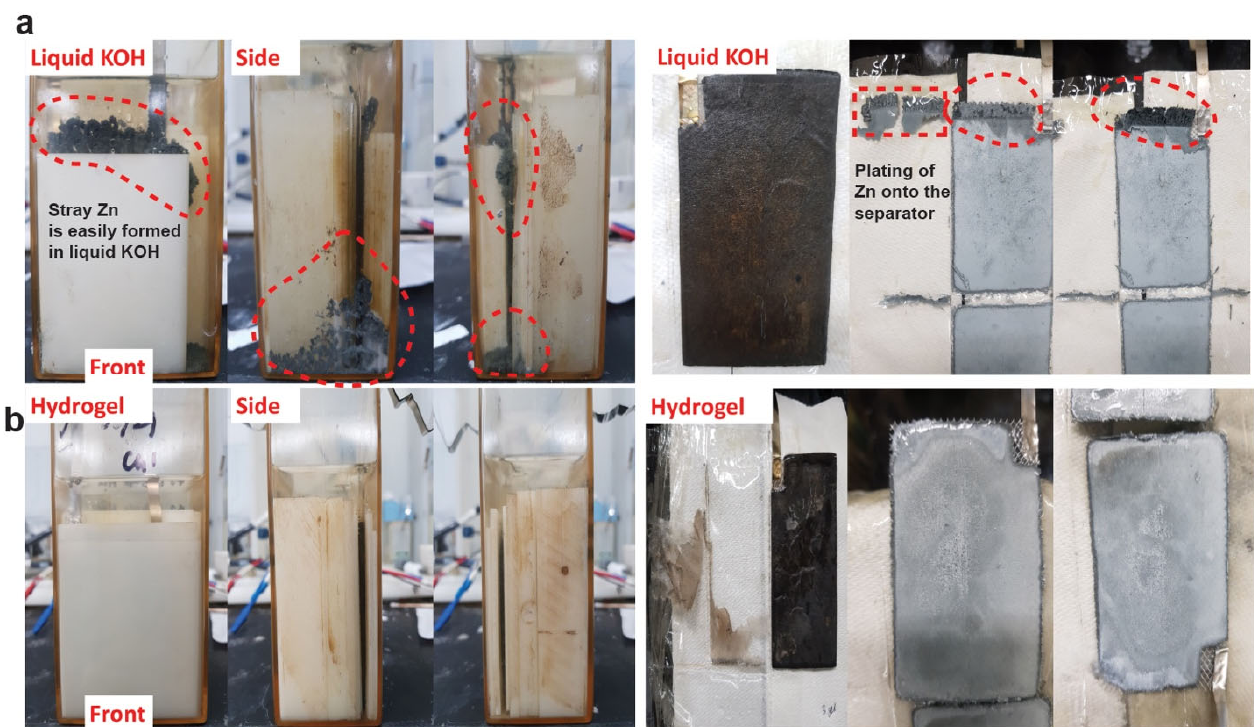
Figure 9. ( a ) Photographs of a Zn anode exhibiting considerable shape change during cycling in a Zn–MnO 2 cell containing liquid 36 wt.% KOH. On the right side, pictures of dissected Zn and MnO2 electrodes are shown. Zn plating is also seen on the cellulose separator. ( b ) Photographs of a Zn–MnO 2 cell containing 36 wt.% hydrogel electrolyte. There is no stray Zn or shape change seen. The electrodes on the right side are also free of any dendritic growth.